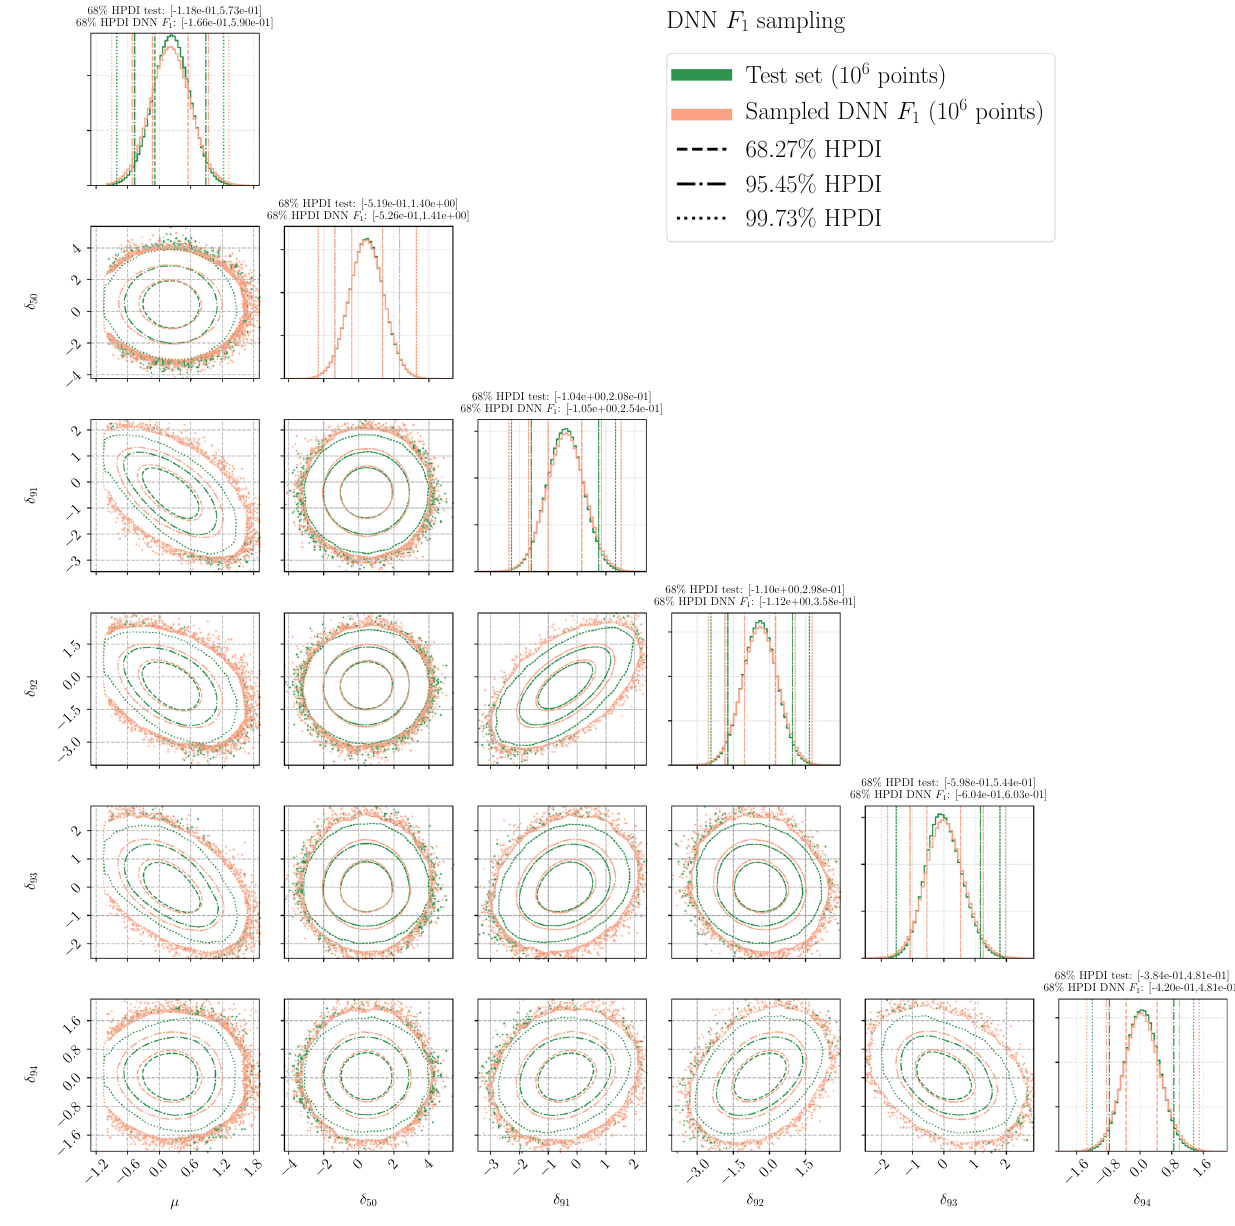
Fig. 14 1D and 2D posterior marginal probability distributions for a subset of parameters from the unbiased S 1 . The green (darker) distribu- tions represent the test set of S 1 , while the red distributions are obtained by sampling the DNNLikelihood F 1 . Histograms are made with 50 bins andnormalisedtounitintegral.Thedotted,dot-dashed,anddashedlines